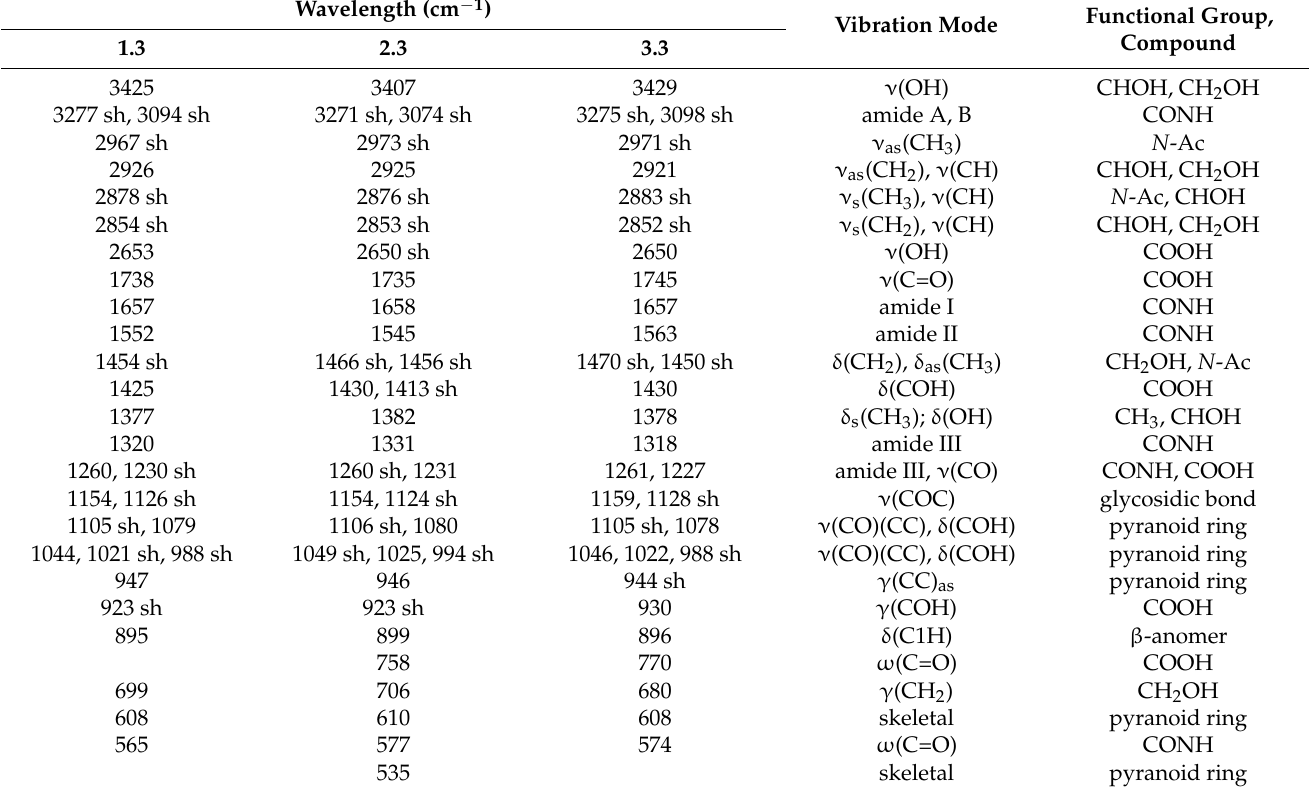
Table 3. Assignment of IR bands of hyaluronic acid for fractions 1.3, 2.3 and 3.3